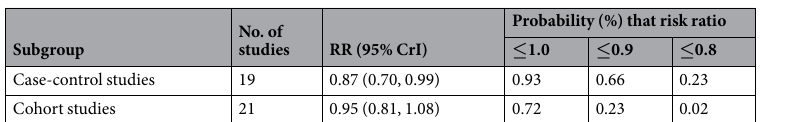
No. of studies RR (95% CrI)